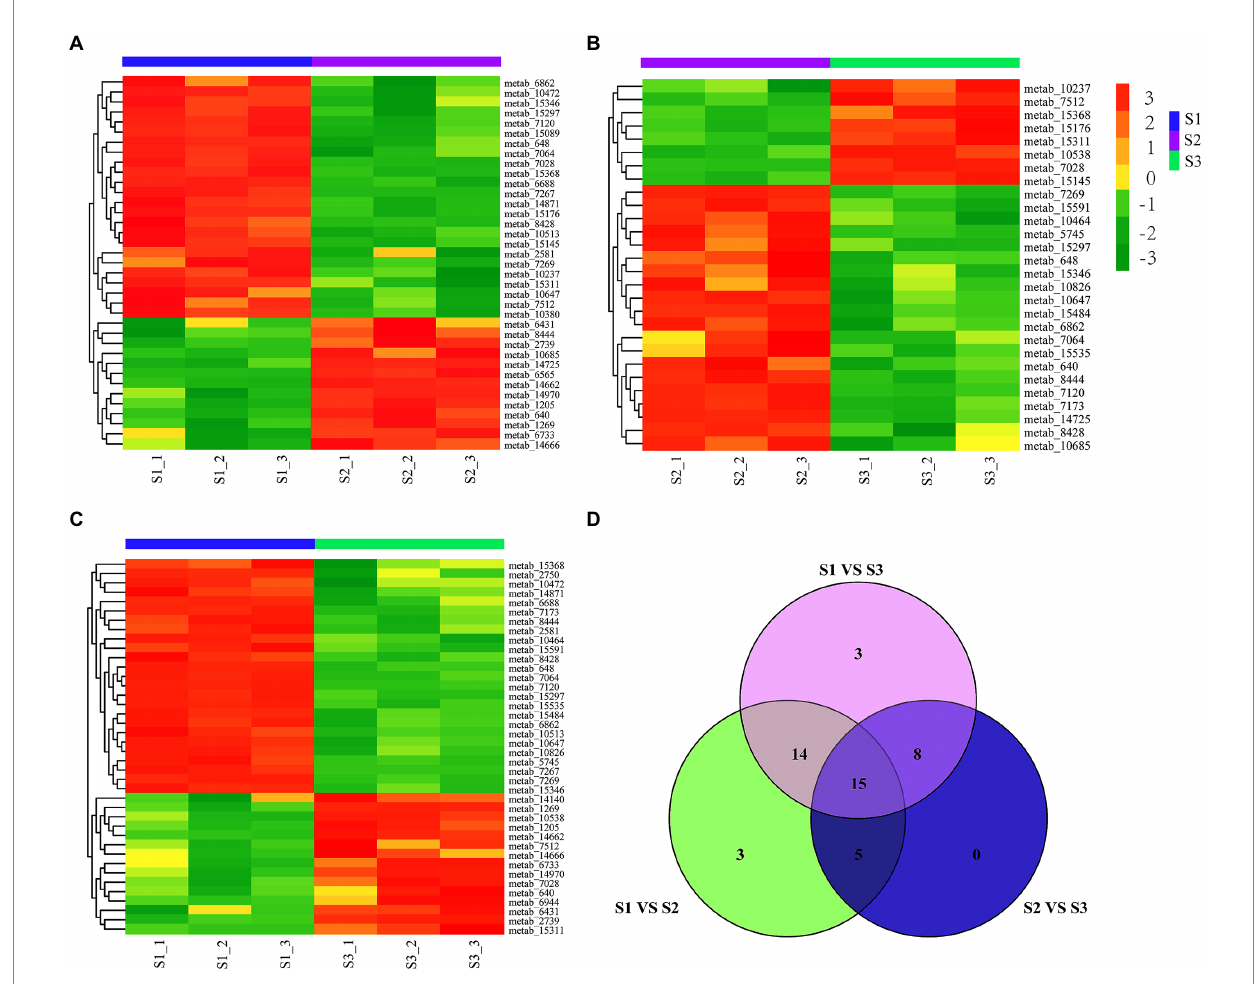
FIGURE 3 Differential flavonoid metabolites in chayote fruits during storage. (A) Differential in S1 vs. S2. (B) Differential flavonoid metabolites in S2 vs. S3. (C) Differential flavonoid metabolites in S1 vs. S3. (D) Venn diagram of differential flavonoid metabolites in different comparison groups. The red and green color in the plot represents higher and lower metabolite contents, respectively. S1, optimal harvest stage; S2, 15 days after storage; S3, 30 days after storage.